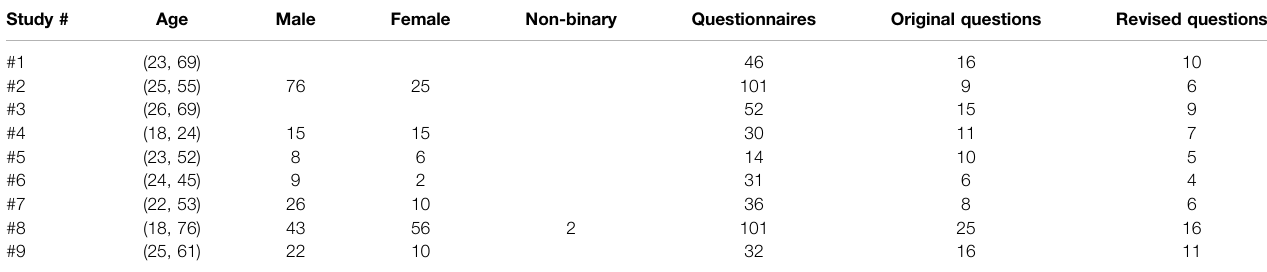
TABLE 1 | Demographic and questionnaire information for each of the nine studies used to revise the embodiment questionnaire. Information includes the range of participant ages, the number of self-identi fi ed male, female and non-binary participants, the total number of questionnaires completed, the number of questions used from the original questionnaire, and the number of questions in the revised